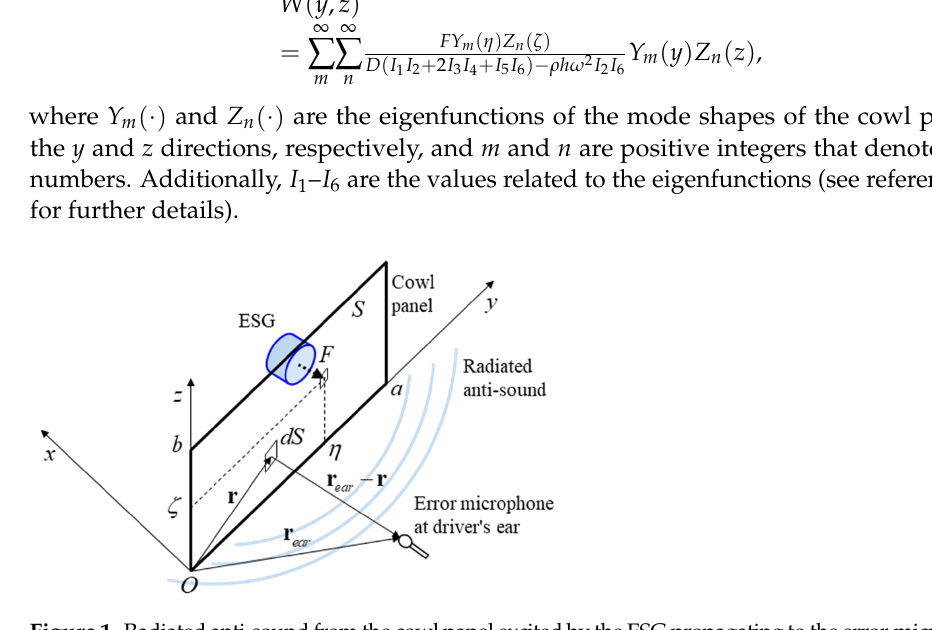
T , the sound pressure p ( r ear , t ) ,